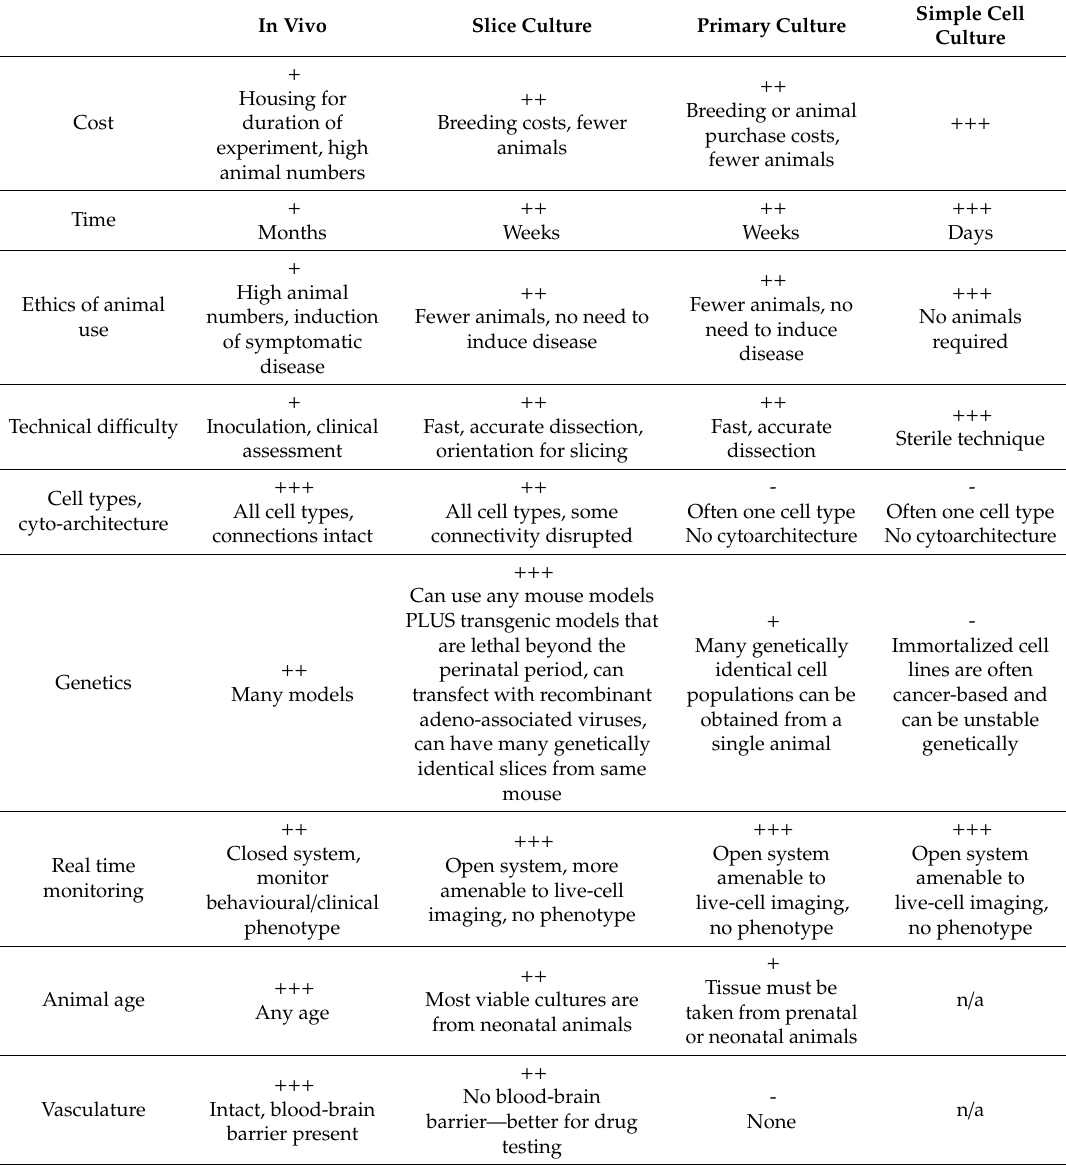
Table 1. Advantages and disadvantages of organotypic slice culture vs. in vivo or cell culture studies. In Vivo Slice Culture Primary Culture